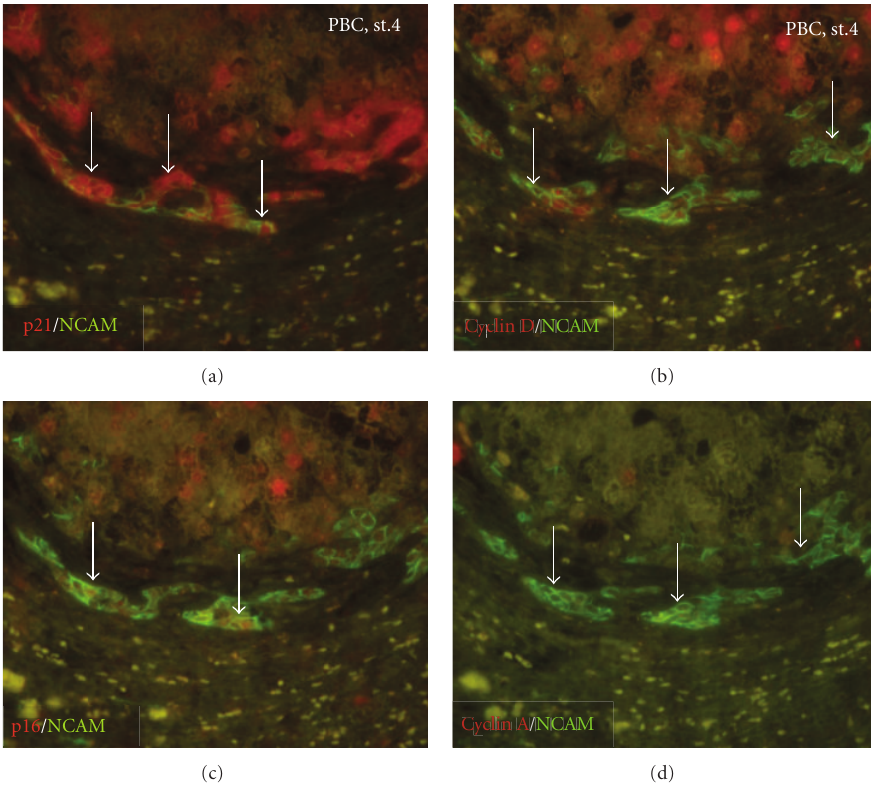
Figure 2: Double immunostaining for senescence markers (p16 INK4a or p21 WAF1 / Cip1 ) and cell cycle markers (G1-phase, cyclin D; S-phase, cyclin A) (red) and NCAM (green) in PBC, stage 4. (a), (c) The expression of senescent markers p16 INK4a and p21 WAF1 / Cip1 is seen in NCAM- positive ductular cells (arrows) in PBC, stage 4. (b), (d) Most NCAM-positive ductular cells (arrows) express cyclin D, whereas there is no cyclin A expression in DRs in PBC, stage 4. Original magnification ×